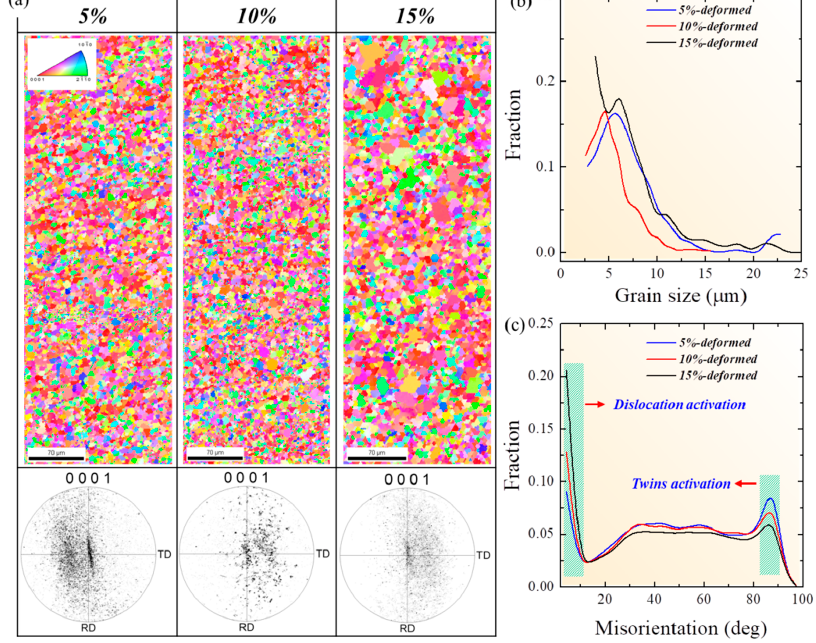
Figure 2. ( a ) Inverse pole figure maps and related 0001 pole figures of the AZ31-Ca Mg alloy samples stretched to 5%, 10% and 15%. ( b ) and ( c ) grain size and misorientation profile of the stretched alloy samples, respectively.